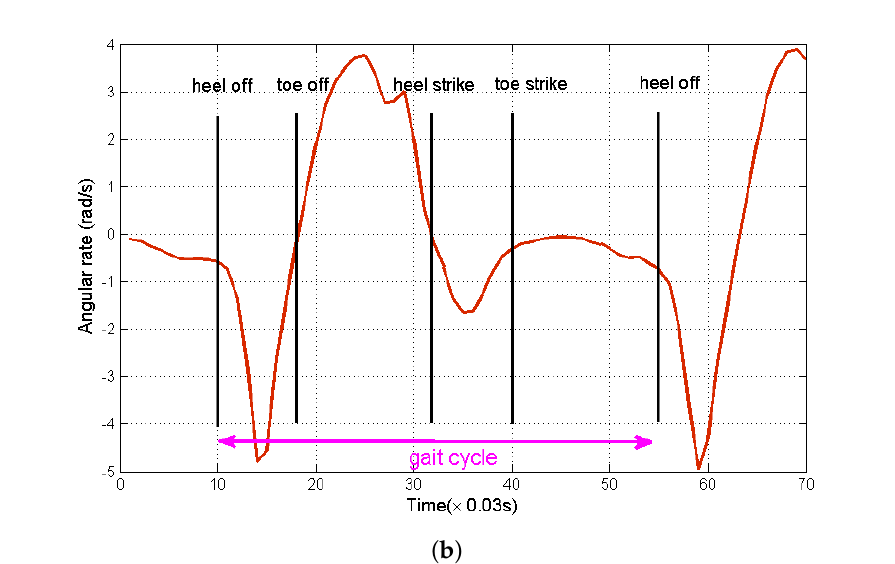
Figure 3. Illustration of the lower body movement during a gait cycle. ( a ) Take the leg in green for example, a gait cycle mainly consists of 6 steps, i.e., (1) the heel leaves the ground (heel off), (2) the toe leaves ground (toe-off), (3) the leg swings forward, (4) the heel contacts the ground (heel-strike), (5) the toe contacts the ground (toe-strike), (6) the stance phase when foot stays on the ground to support the other leg swing forward; ( b ) The gyroscope signal in the sagittal plane during a gait cycle, where the gyroscope signal is close to 0 and the variations are subtle during the stance